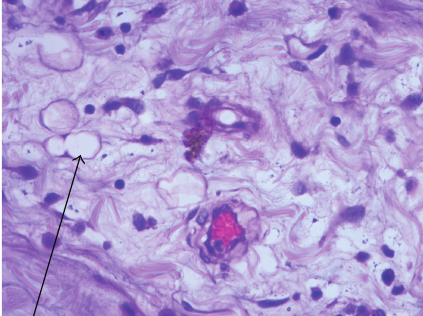
Figure 5: H&E stain (high magnification). Vascular spaces filled with clear chylous fluid (arrow). H&E stain × 100.